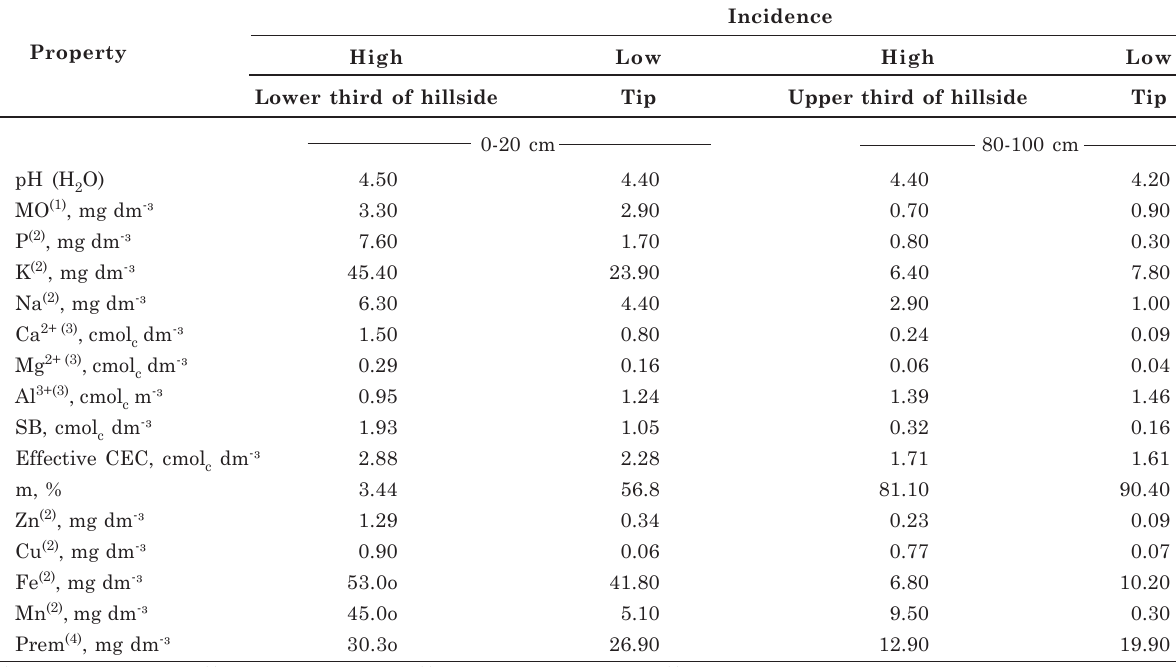
Table 3. Properties of the soil in areas where eucalyptus plants were sampled with high or low incidence of ESBVRD